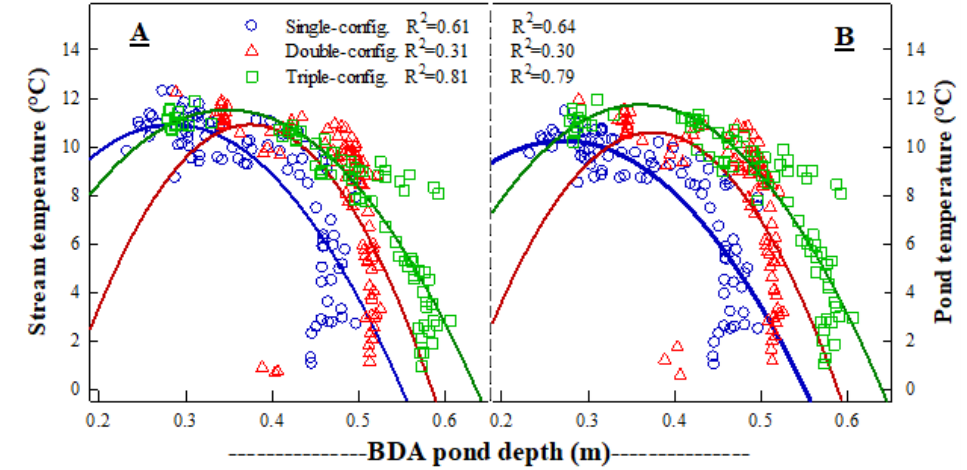
Figure 8. Relationships of daily BDA Pond depth with respective stream ( A ) and pond ( B ) temperatures to show the role of ponding on the respective temperature regimes above or below different BDA configurations.